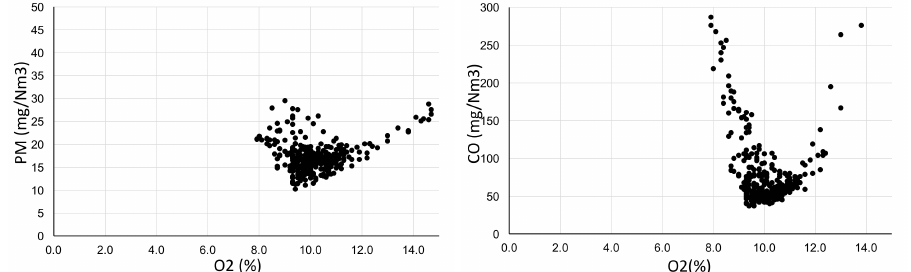
Figure 7. PM–O 2 correlation with high CO level ( left ); CO–O 2 correlation with high CO level ( right ). CO and PM are referred at O 2 13%. Data plotted are the instantaneous values collected during